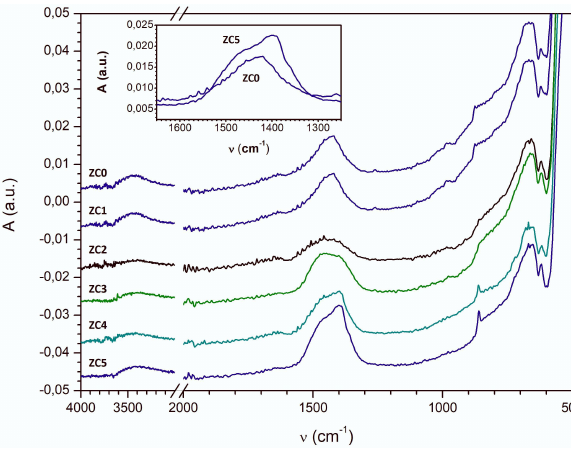
Figure 4: FTIR spectra of mechanochemically prepared samples with various shares of dopant. Inset: portion of the spectra of samples ZC0 and ZC5 between 1650 and 1250 cm −1 . Table 1: The dependence of zincite crystallite size, bandgap and specific surface area on cadmium share.